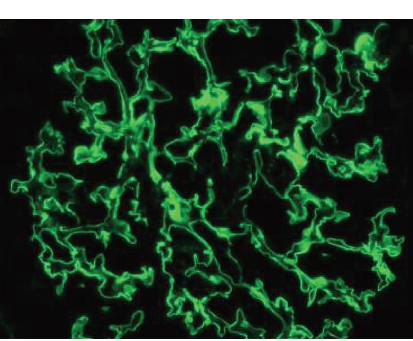
Figure 1: Immunofuorescent antibody staining of glomeruli demonstrating linear deposition of IgG anti-GBM antibodies.